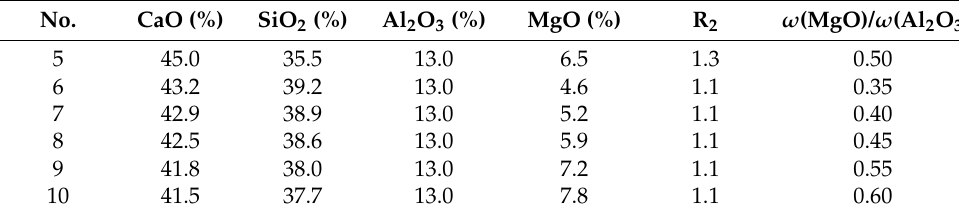
Table 1. Chemical composition of the CaO–SiO 2 –Al 2 O 3 –MgO slag system.